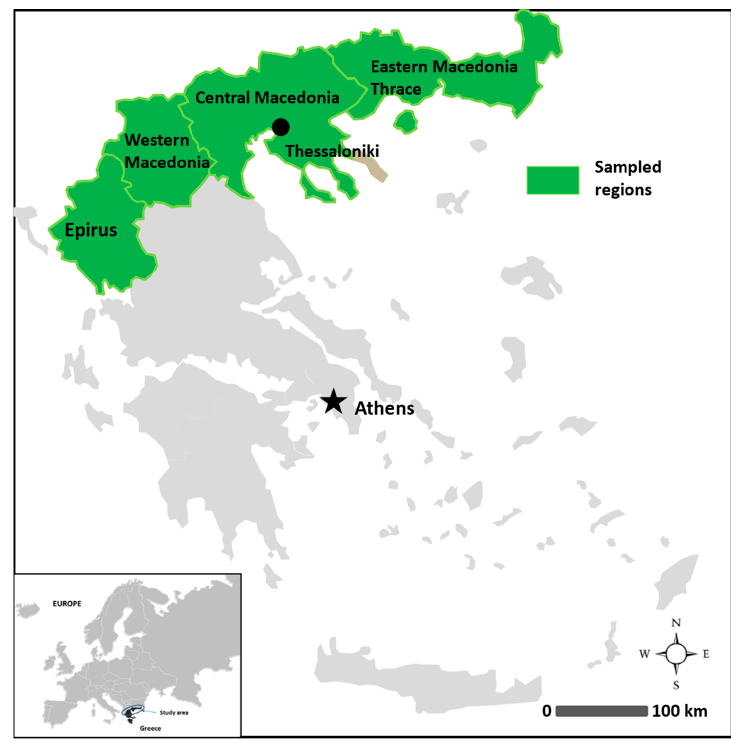
Figure 1. Map of the study area.